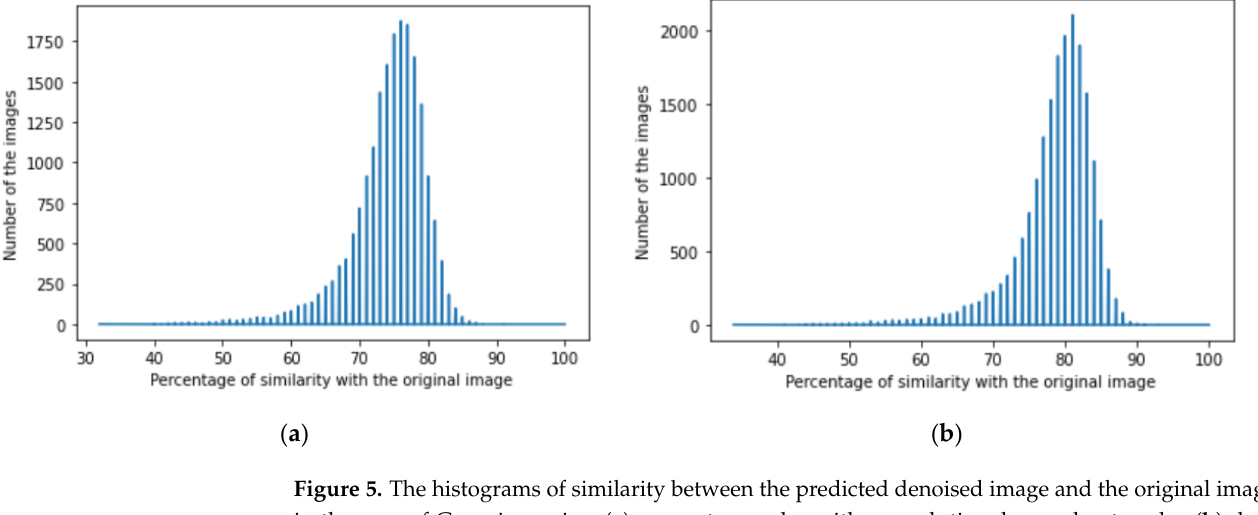
Figure 5. The histograms of similarity between the predicted denoised image and the original image in the case of Gaussian noise: ( a ) one autoencoder with convolutional neural networks; ( b ) dual autoencoder with convolutional neural networks.